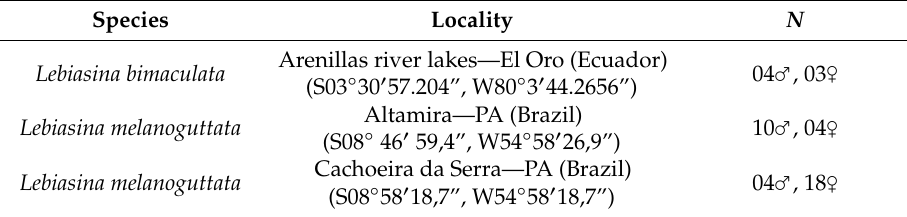
Table 2. Collection sites of the Lebiasina species analyzed with the sample size ( N ). Species Locality